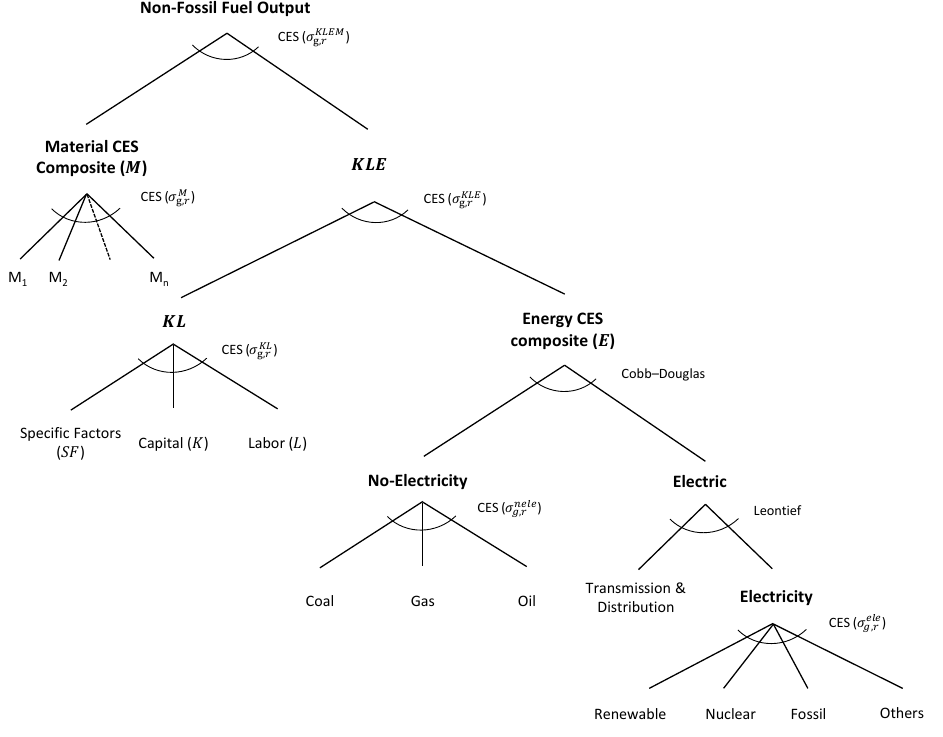
Figure 1. Nesting structure in non-fossil fuel production